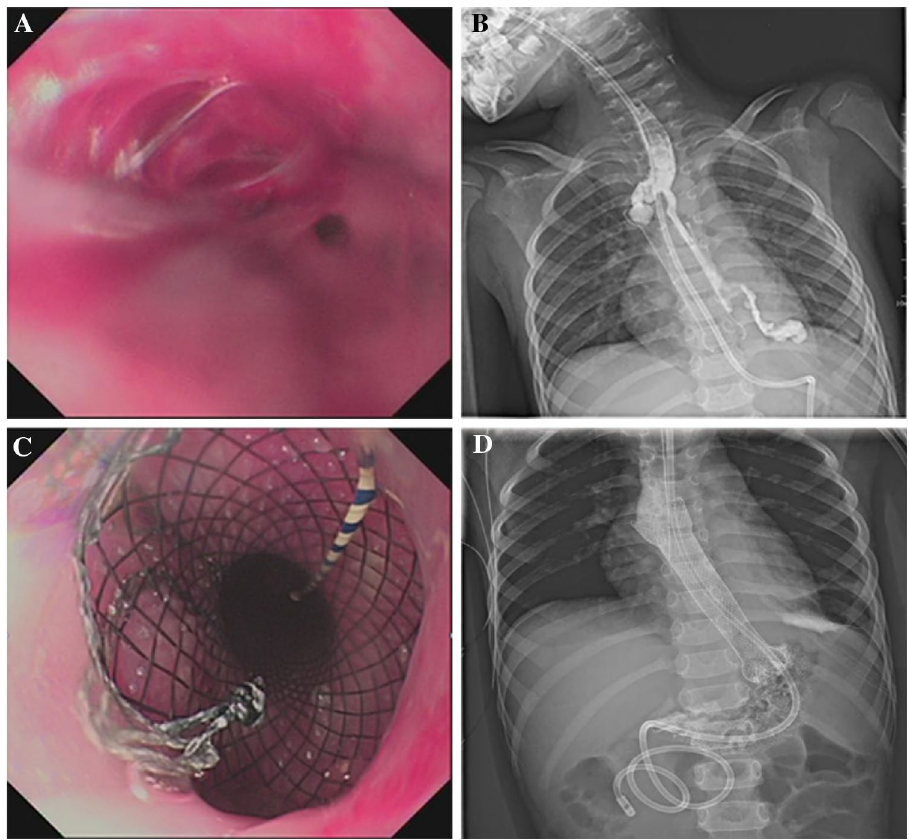
Figure 5. Stent placement in a patient with an EBD-induced esophageal perforation (case 14). ( A ) Esophageal perforation secondary to endoscopic balloon dilatation, the upper oral mucosa of the stricture was torn and bleeding; ( B ) Stent malapposition occurred 5 days after the first stent implantation; upper gastrointestinal tract radiography revealed that contrast medium infiltrated the mediastinum; ( C ) The original esophageal stent was replaced by a redesigned stent with larger upper bell mouth; ( D ) After the second esophageal stent was placed, upper gastrointestinal tract radiography revealed that the fistula was plugged, without contrast medium extravasating.